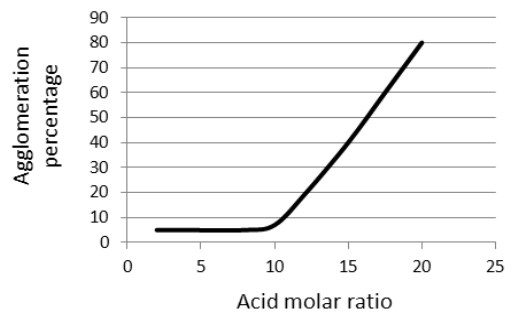
Figure 6. Relation between acid molar ratio and agglomeration of